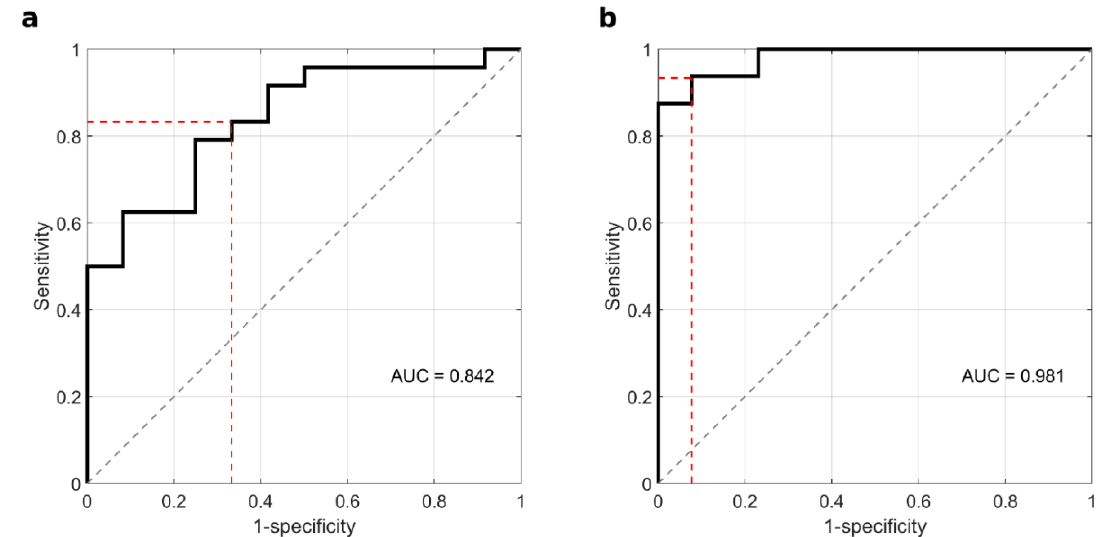
Figure 6. Sex-disaggregated ROC curves for ( a ) women and ( b ) men, obtained by LDA in the 2-parameter space of the 20–30 kDa integral area and the alpha 2 level.